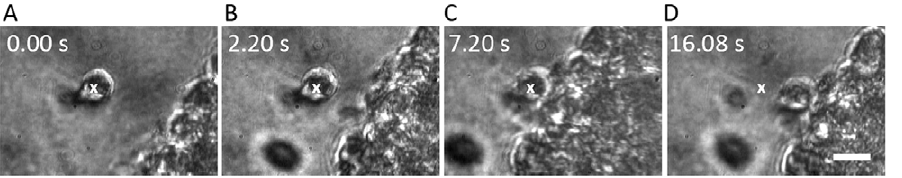
Figure 7. Time-lapse images of membrane-mediated cell adhesion dynamics. A) – D) Real-time images (Movie S4) demonstrating adhesion of a single progenitor cell to a neurosphere in the absence of filopodia. The white cross denotes the position of the optically-trapped cell being brought towards the neurosphere. Panels C) and D) show that irreversible adhesion occurs after approximately 5 seconds. Note that the surfaces of both are juxtaposed closely, indicating membrane-membrane adhesion. The scale bar denotes 10 m